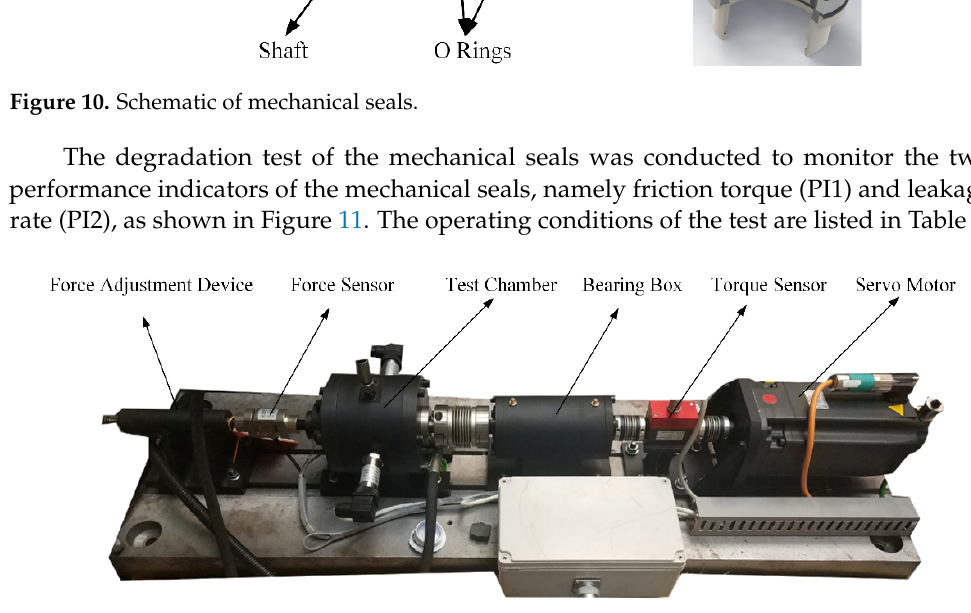
Figure 11. Degradation test rig used for the degradation test of mechanical seals.